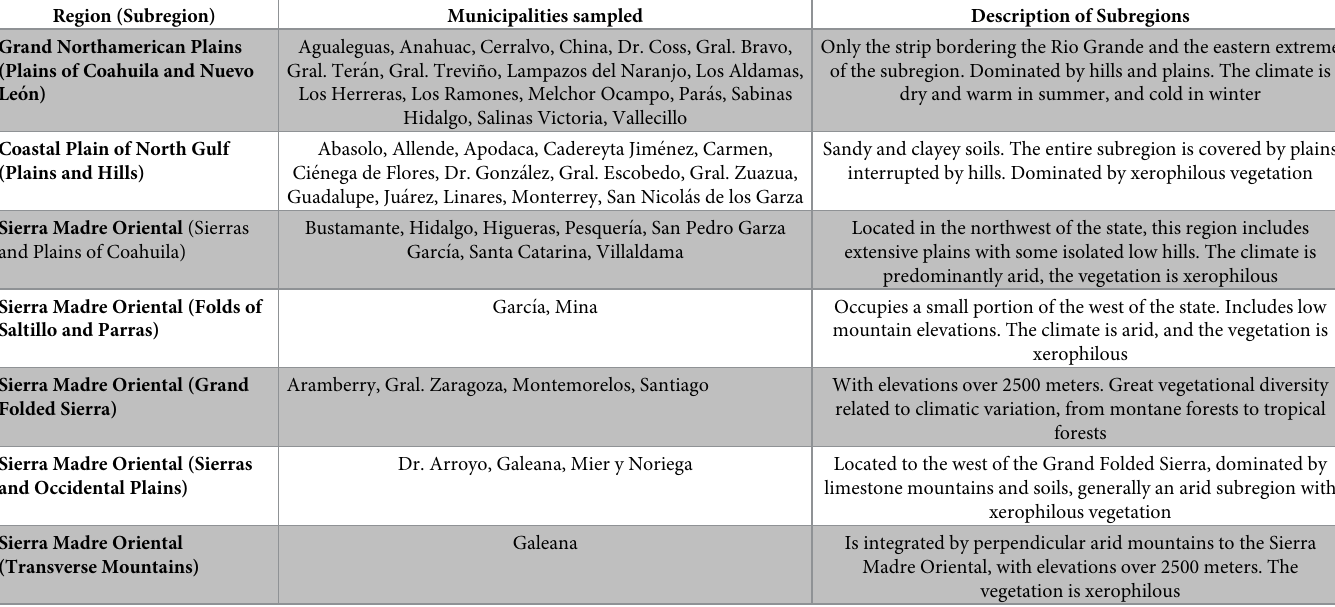
Table 2. Description of the physiography of Nuevo Leo´n state and list of municipalities sampled. Region